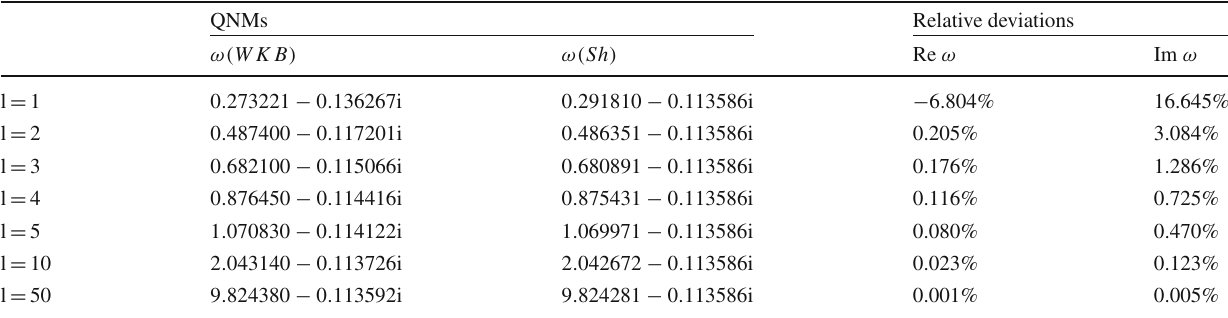
Table 9 The QNMs derived by the WKB approximation approach and shadow radius and the relative deviations. In the calculation, we let Q = 0 . 7 and α = − 1